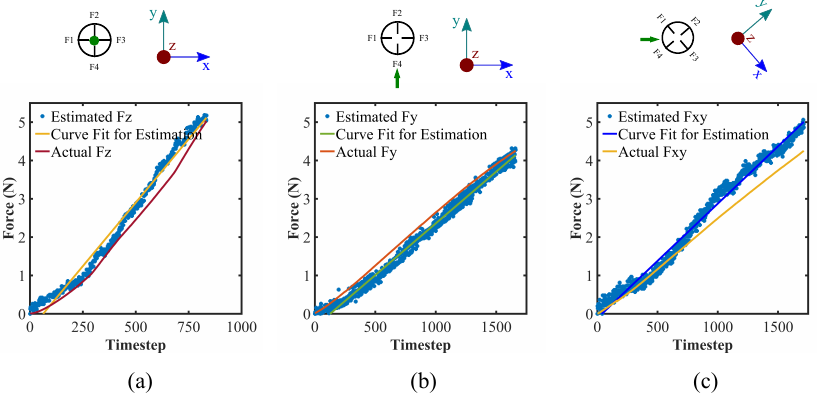
Figure 8. Force estimation utilizing sensor data and calibration matrix; applied force direction along ( a ) z-axis, ( b ) y-axis, and ( c ) line with 45 ◦ from the